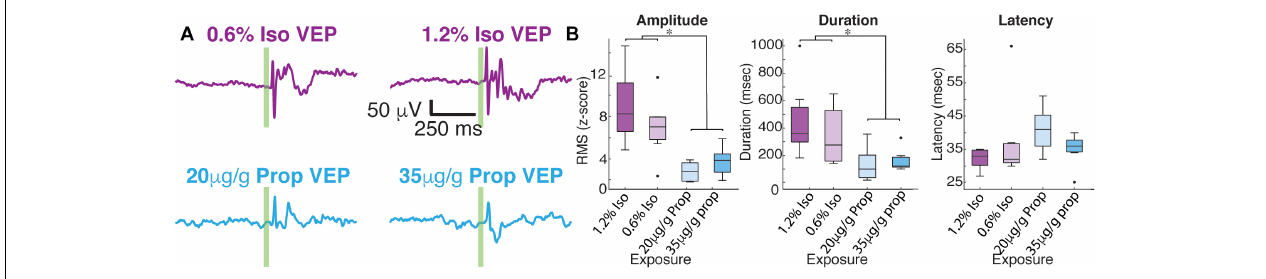
FIGURE 3 | Average visual evoked responses under isoflurane and propofol are dramatically different within the same animal. (A) Average of 100 flash trials under each does of isoflurane (top) and propofol (bottom). The flash is denoted by the green vertical line. (B) Quantification of average VEP amplitude ( n = 7, p -value amplitude < 0.001, Mann–Whitney U -test with post hoc Bonferroni Correction), duration of VEP ( n = 7, p -value duration = 0.003, Mann–Whitney U -test with post hoc Bonferroni Correction), and latency of onset ( df = 3, n = 7, p -value = 0.044, Kruskal–Wallis). asterisks ( ∗ ) denote p < 0.01.